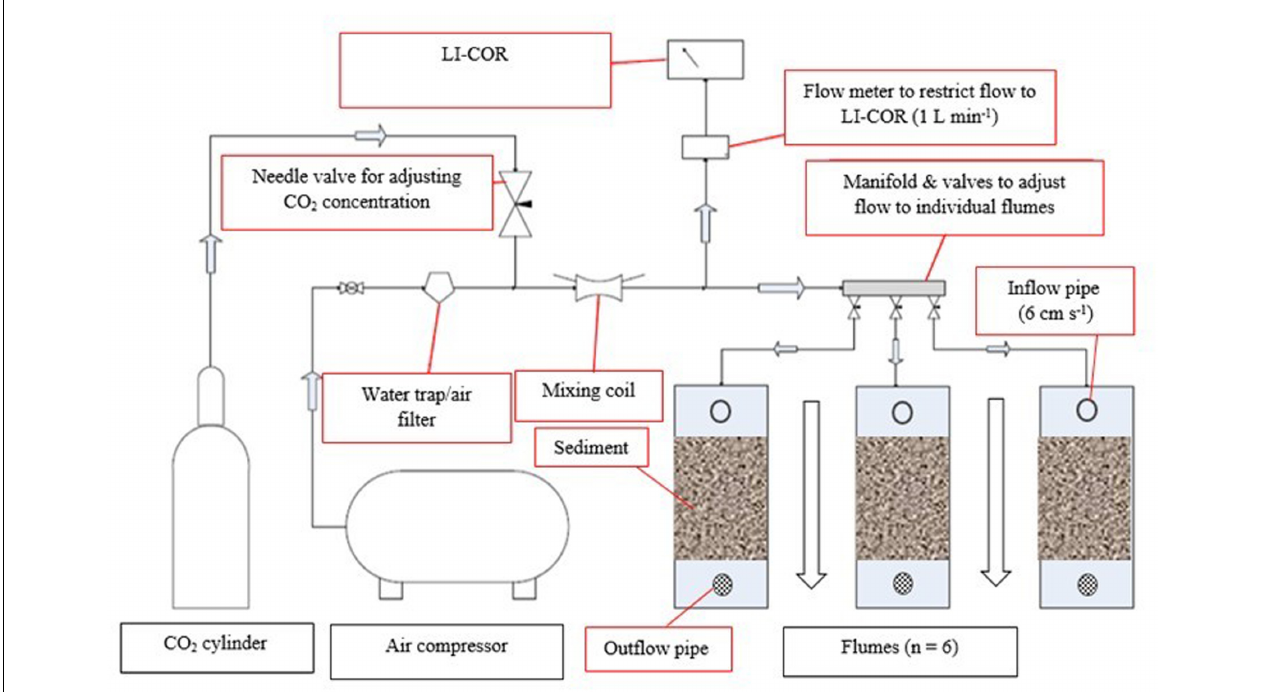
FIGURE 1 | Experimental set up of the elevated CO 2 system (750 ppm CO 2 ). Dried ambient air from an external compressor is mixed with pure CO 2 in a mixing coil and flowing (1 L min − 1 ) into individual flumes and through a LI-COR 820 for continuous monitoring of concentration. The same set up was used for the ambient CO 2 treatment ( ∼ 380 ppm CO 2 ) for another three flumes, but without the addition of pure CO 2 . A recirculating flow of seawater via the inflow- and outflow-pipe was restricted to 6 cm s - 1 and provided a unidirectional flow (indicated by a black-outlined